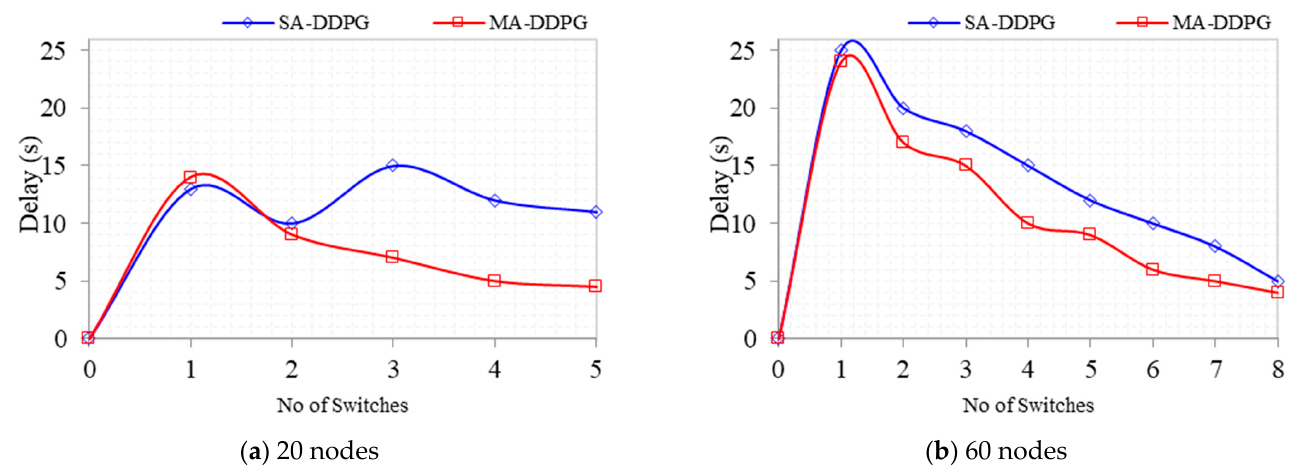
Figure 12. Delay vs. no. of switches for SA ‐ DDPG and MA ‐ DDPG.